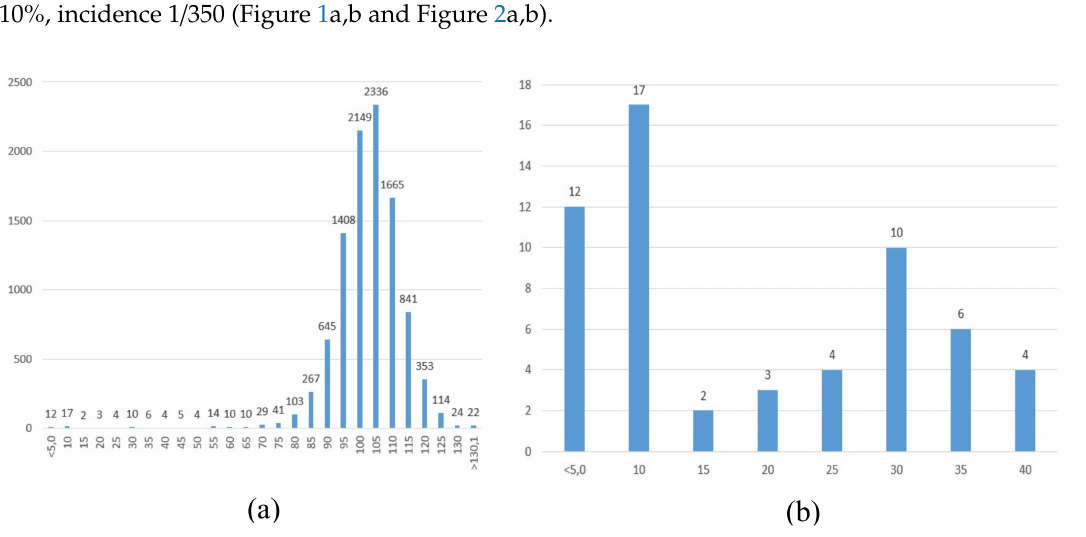
Figure 2. ( a ) Distribution of glucose-6-phosphate dehydrogenase activity in 10,098 screened samples, expressed as percent of the days mean. ( b ). Distribution of glucose-6-phosphate dehydrogenase activity in samples ( n = 58) with ≤ 40% residual activity, expressed as percent of the days mean, analysed as singletons.